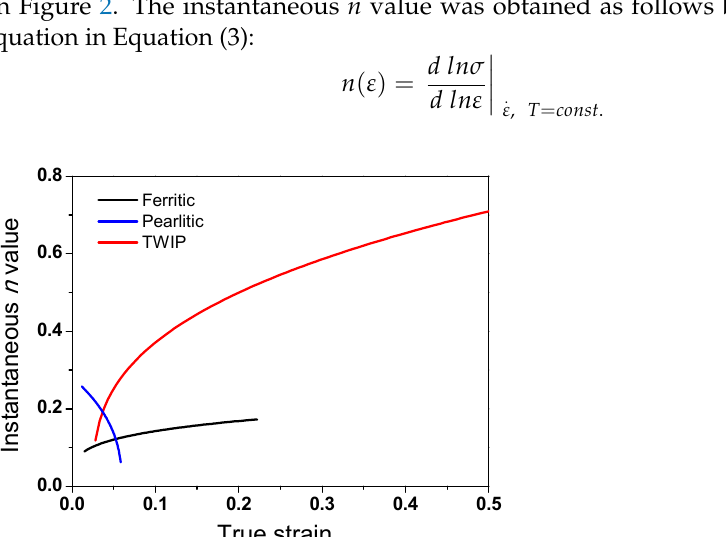
Figure 15. Comparison of the variation in instantaneous n values for the hot-rolled ferritic, pearlitic, and TWIP steels with strain.